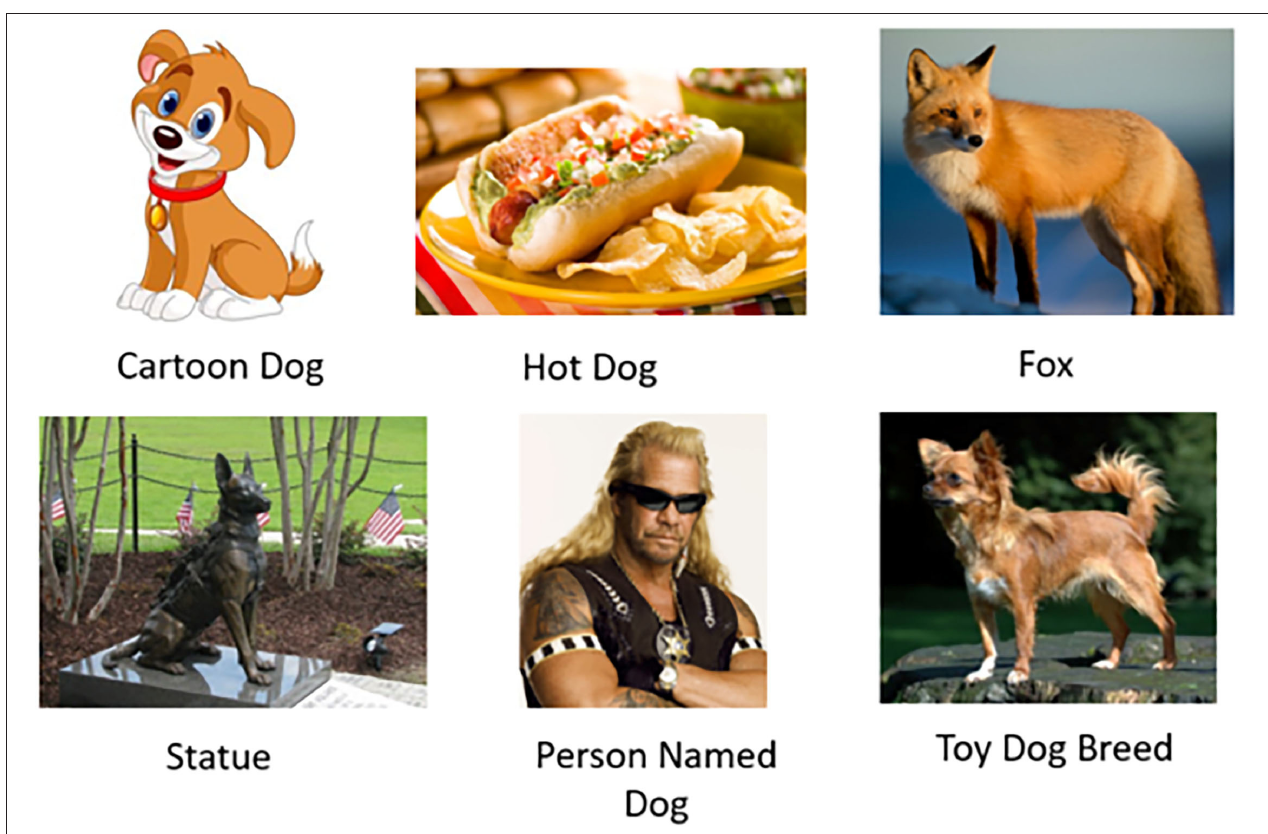
FIGURE 5 | Ambiguous examples and concept tags provided by workers in Stage 1 (FIND) for the task “Is there a dog in this image?” We capitalize tags here for presentation but use raw worker tags without modification in our